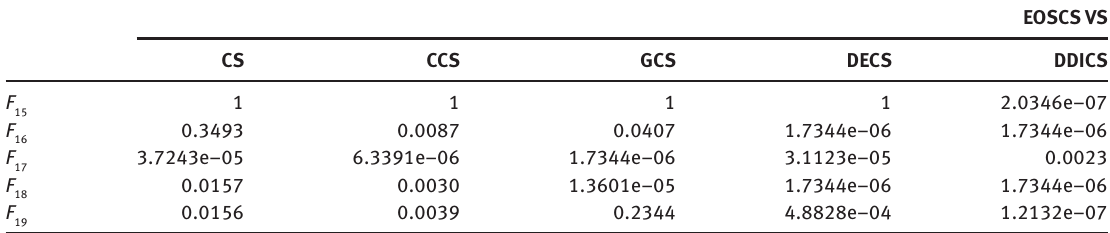
Table 12: p -Values Produced by Wilcoxon’s Test Comparing EOSCS versus CS, EOSCS versus CCS, EOSCS versus GCS, EOSCS versus DECS, and EOSCS versus DDICS Over the “Average Best-So-Far” Values from Table